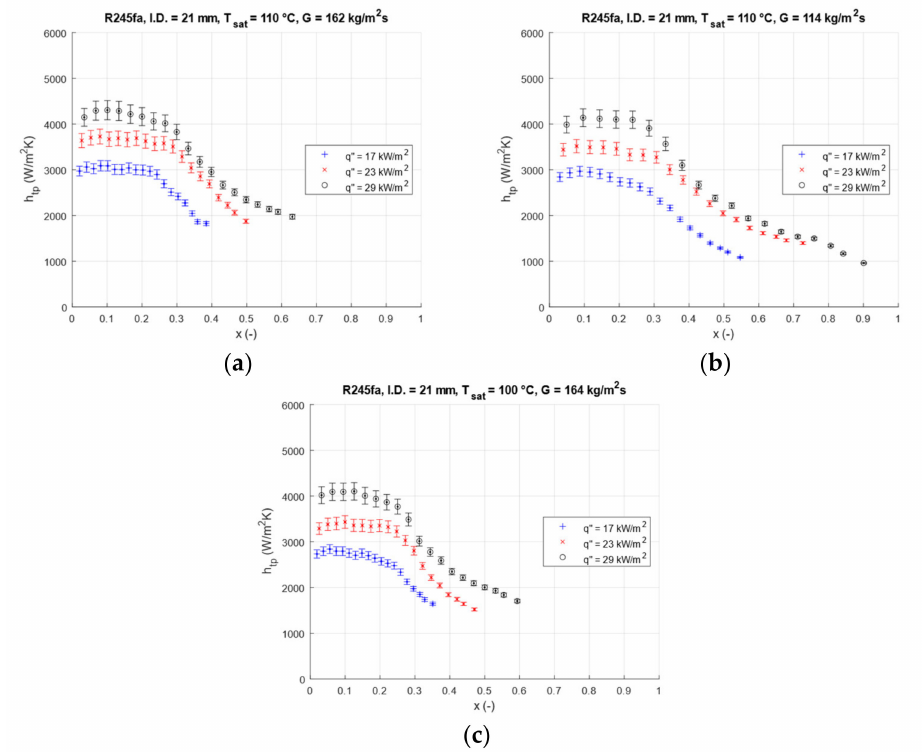
Figure 9. Local experimental two-phase heat transfer coefficients at changing heat flux, at